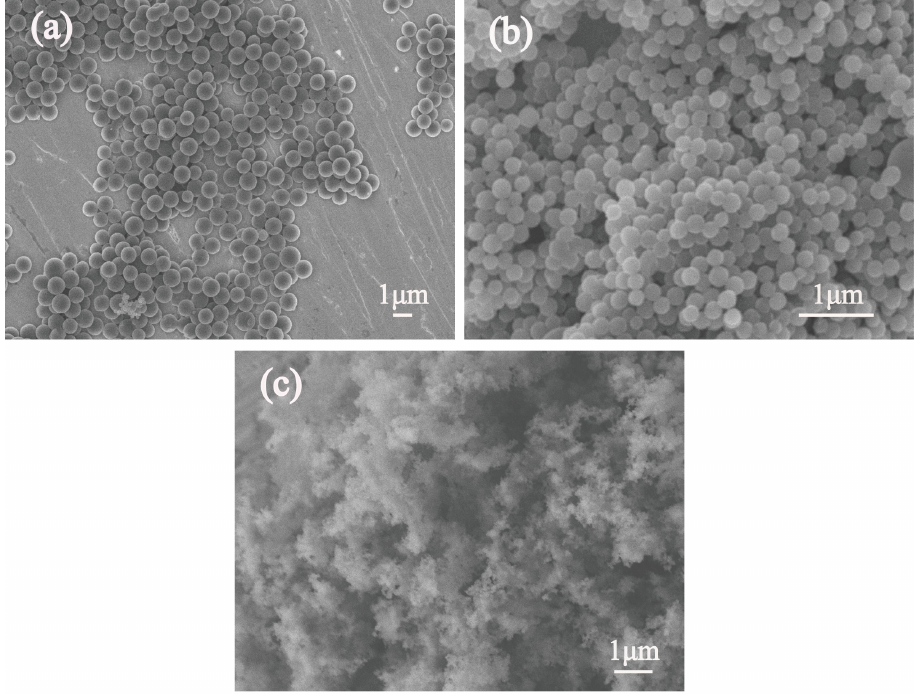
Figure 4. SEM images of ( a ) MCs-0, ( b ) MCs-1, and ( c ) MCs-2.